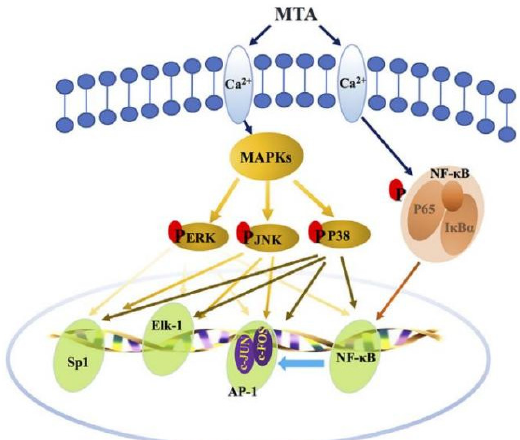
Figure 3. Schematic diagram of the activation of NF- κ B and MAPK pathways by MTA treatment. Reprinted/adapted with permission from Ref. [23]. 2018, Yu, J.